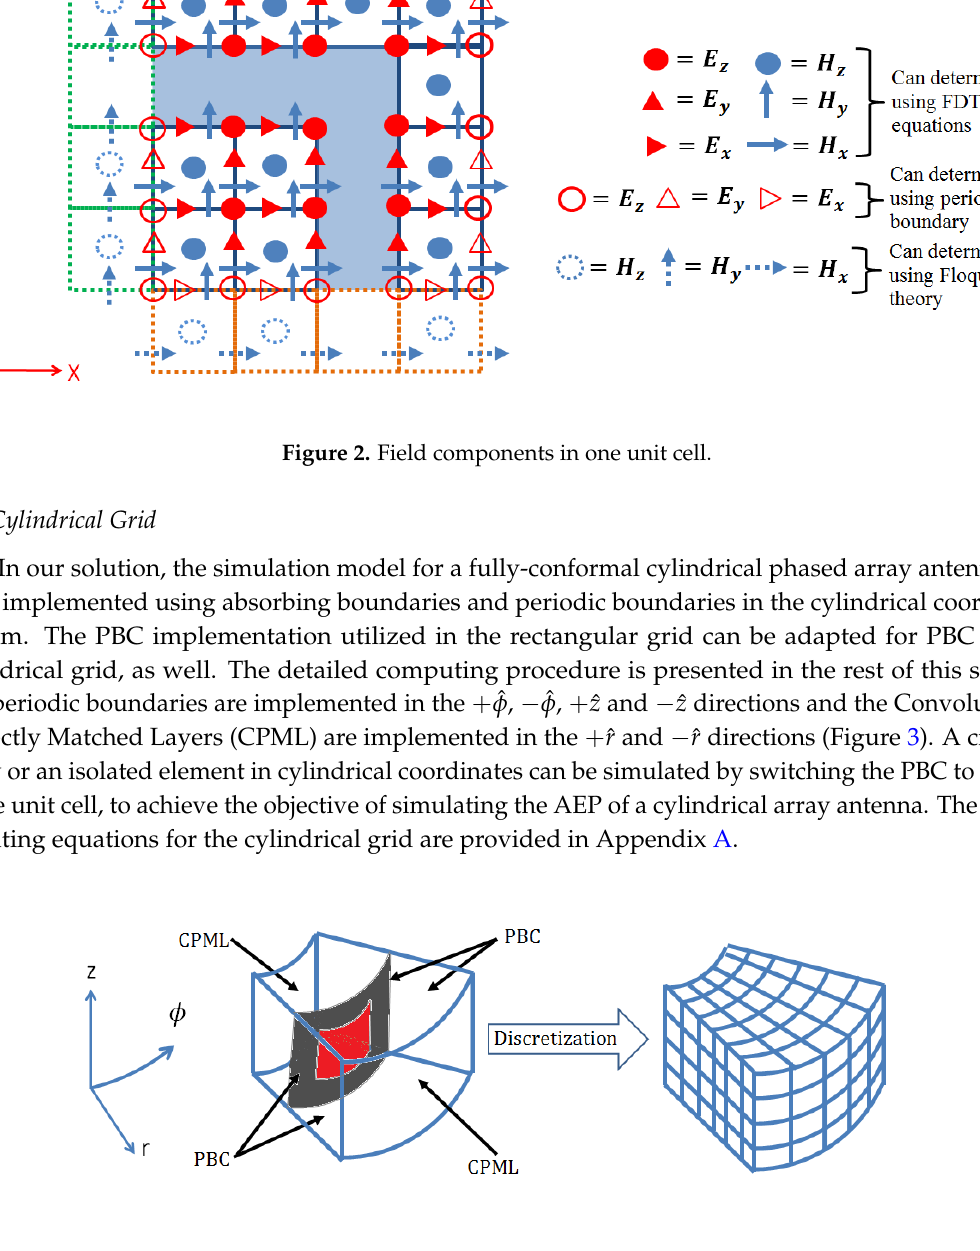
Figure 3. Unit cell for FDTD simulation for a cylindrical array. This unit cell has one patch antenna of an infinite cylindrical array. The red color area is the metal patch and gray color area is the substrate